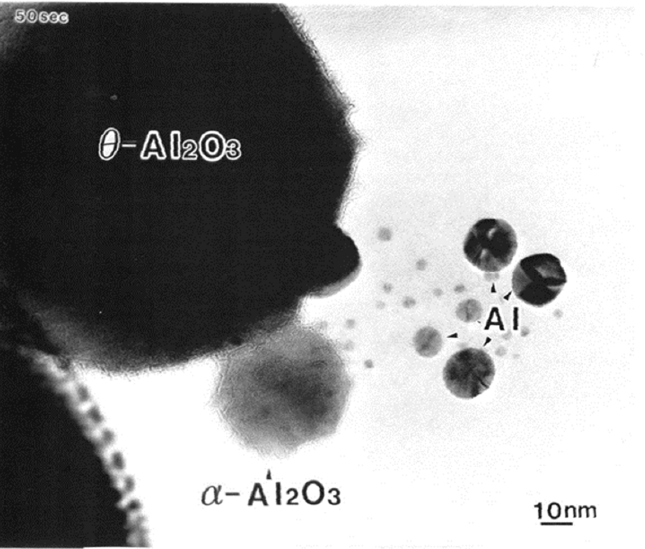
Figure 2. Al nanodecahedra of 10–17 nm in diameter and α -Al 2 O 3 nanoparticles obtained by electron irradiation of metastable θ -Al 2 O 3 with an intensity of 2.1 × 10 20 e/cm 2 s in TEM [3].